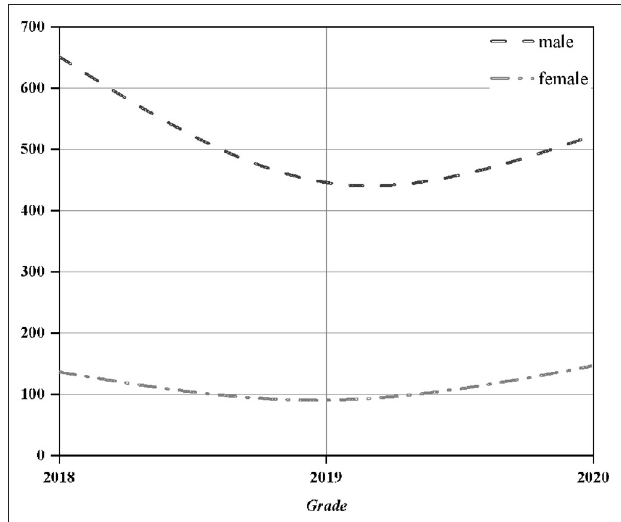
FIGURE 6 | Information on the student questionnaire of the school of